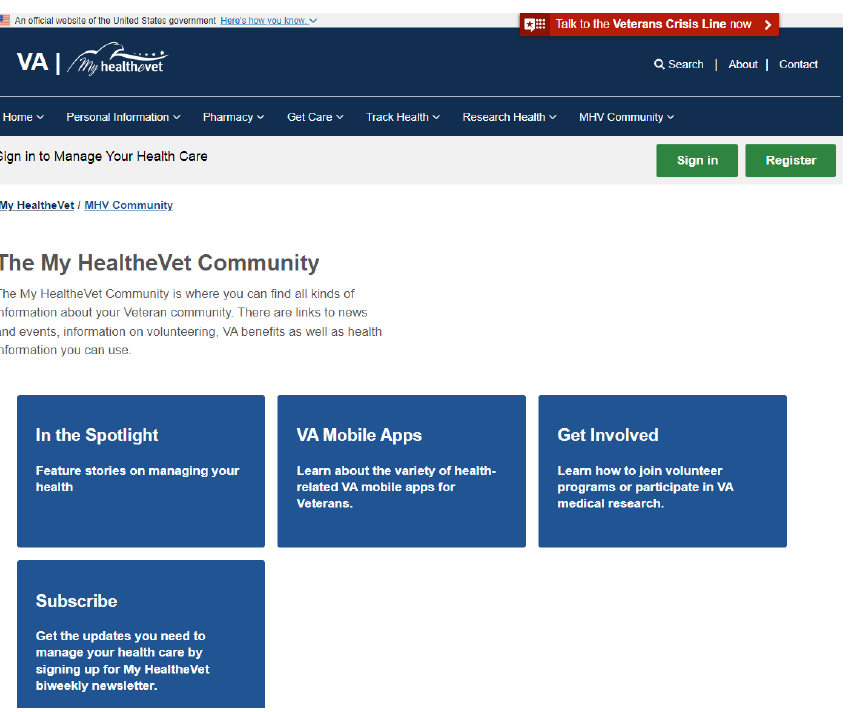
Figure 9. My community section in